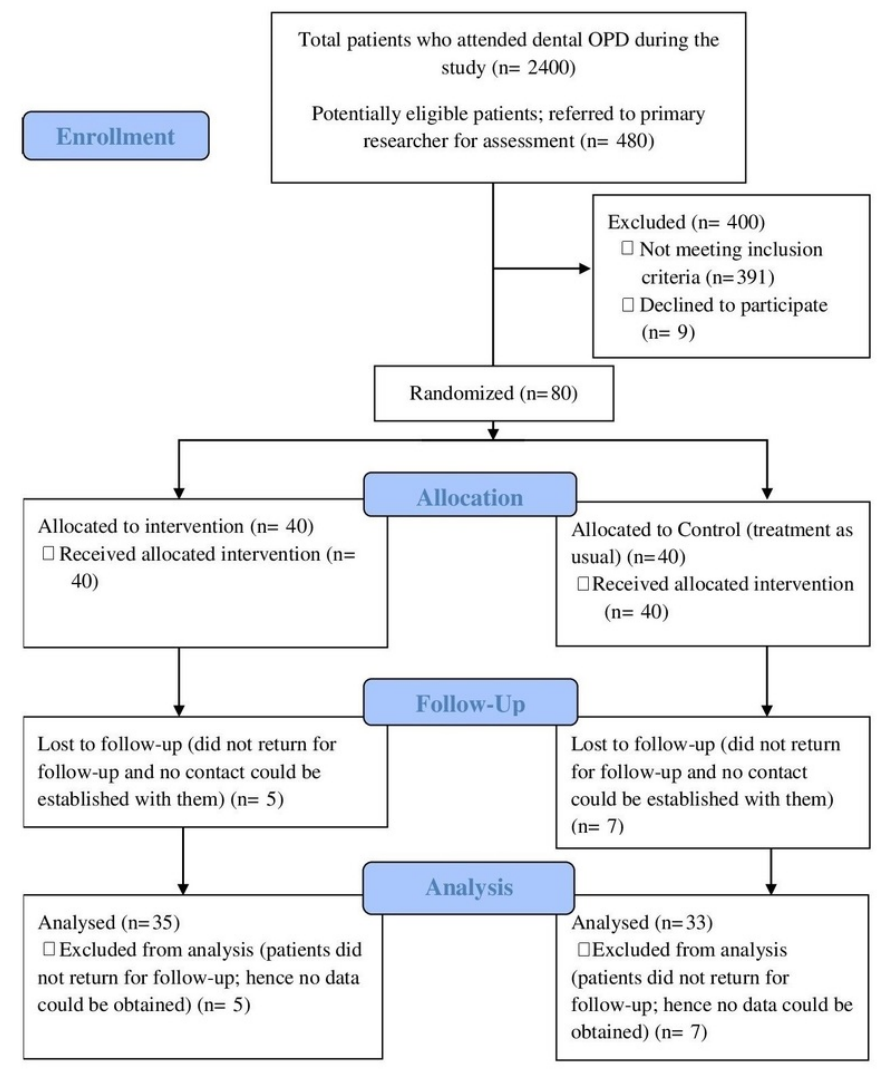
Figure 2. CONSORT patient flow diagram. Table 2. The di ff erence in the mean pain scores between groups.